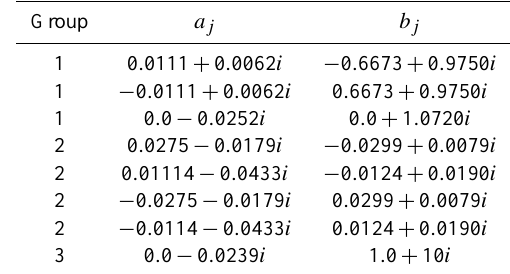
Table 1. Poles ( b j ) and residues ( a j ) of the transformation in Fig. 2. Only poles in the upper half-plane are included in this